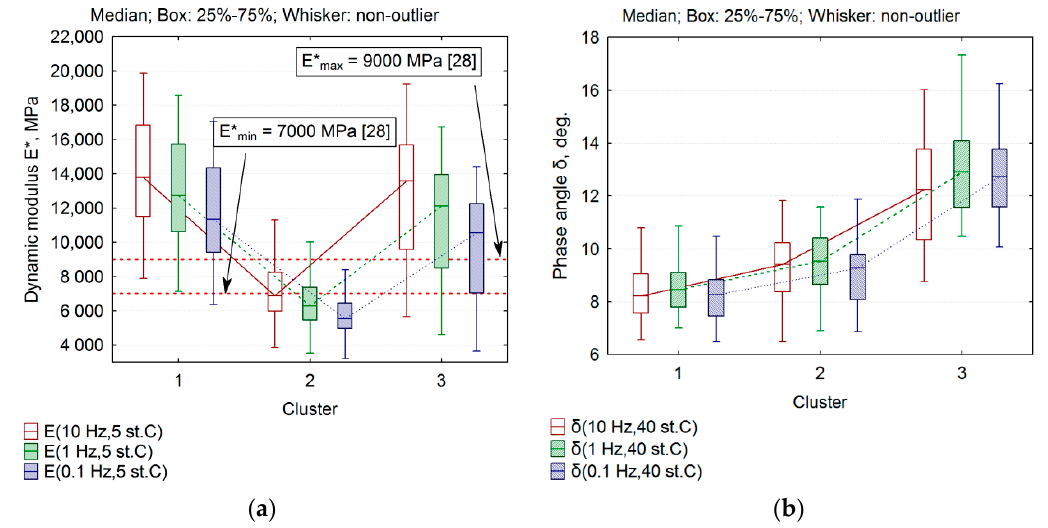
Figure 4. Grouping of the mixes based on: ( a ) dynamic modulus (E) at 5 °C; ( b ) phase angle ( δ ) at 40 °C.